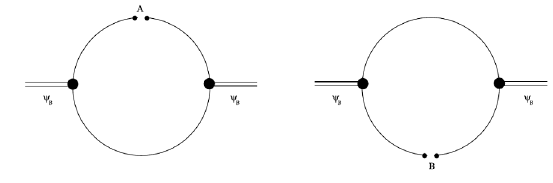
Figure 1. Feynman diagrams for the calculation of X for a bound state represented by the double lines. The two filled dots correspond to insertions of a number-operator